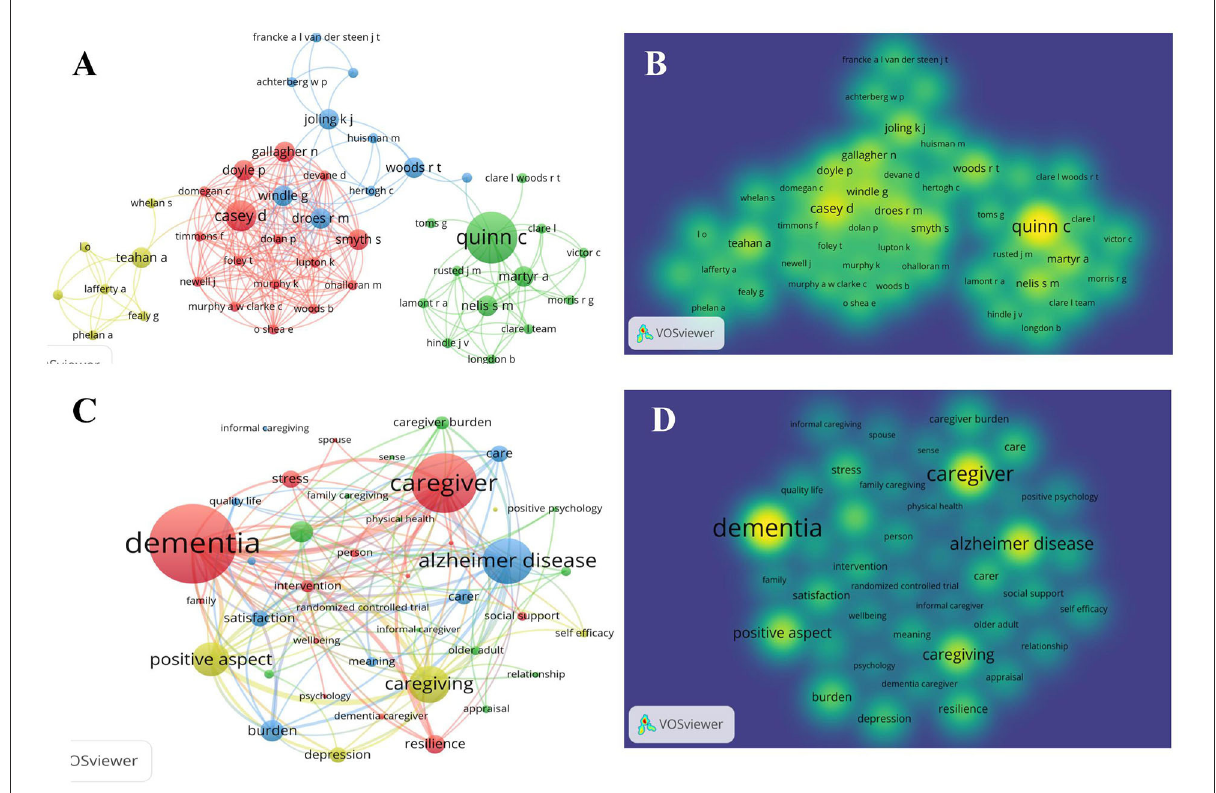
FIGURE2 Network analysis of authors and keywords using the density visualization module of VOSviewer software. (A,B) Network of authors. (C,D) Network of keywords.